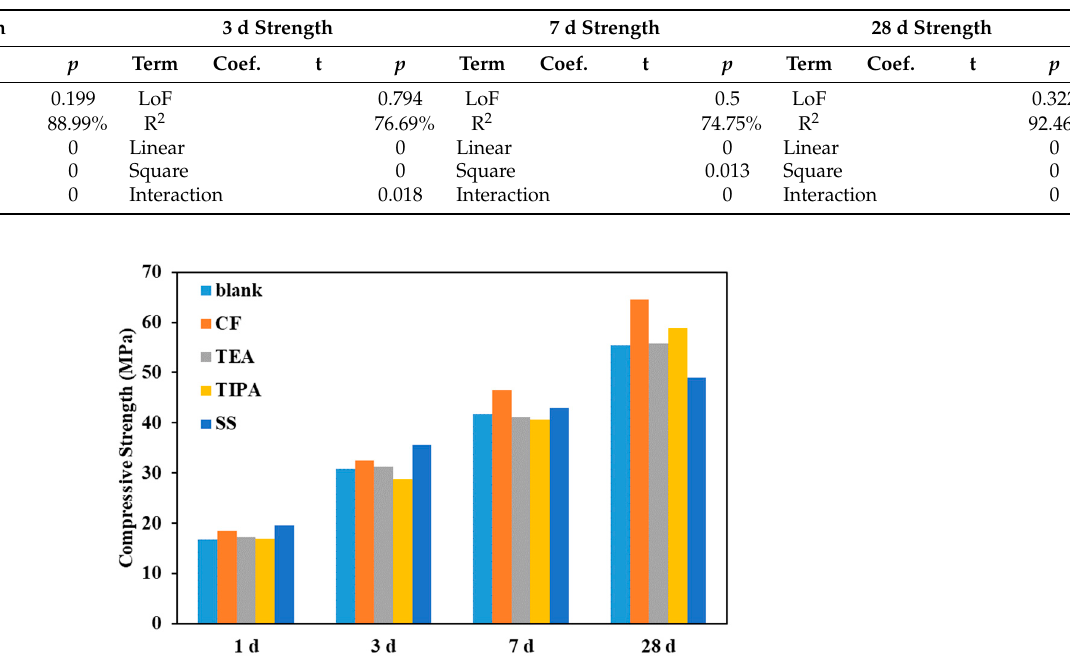
Figure 1. Effect of each admixture on the compressive strength of mortars (the content of each admixture refers to the high level in Table 3). Table 4. ANOVA of the final CCFD models for compressive strength of mortars.